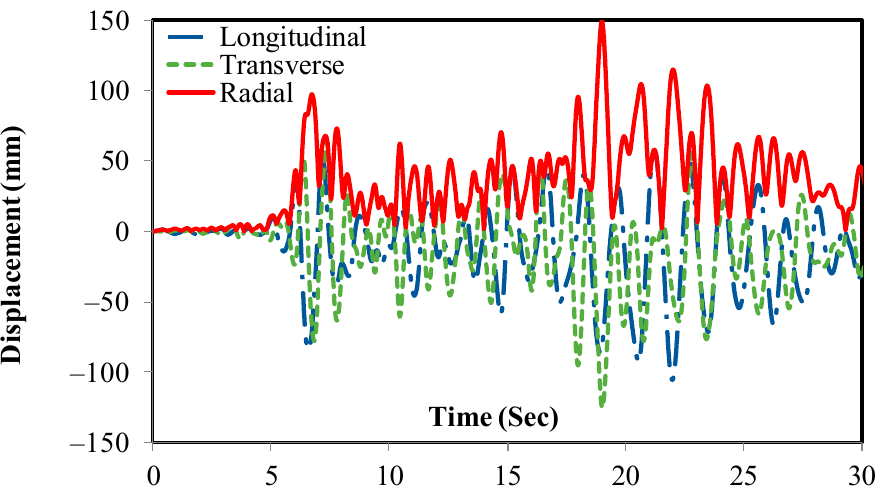
Figure 6. An example of the time history results for the longitudinal, transverse and radial dis- placements.